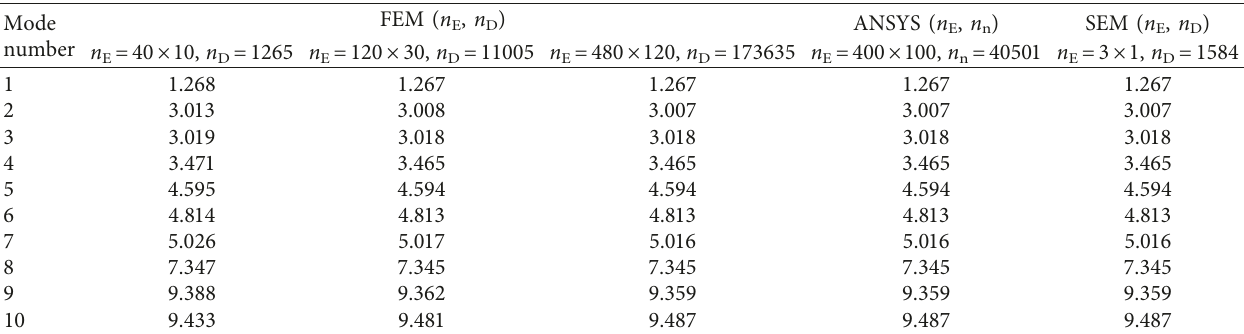
Table 2: Comparison of the natural frequencies (Hz) of the three-span plate with S-S-S-S supports (Example 4) obtained by the FEM [38], ANSYS [39], and SEM.